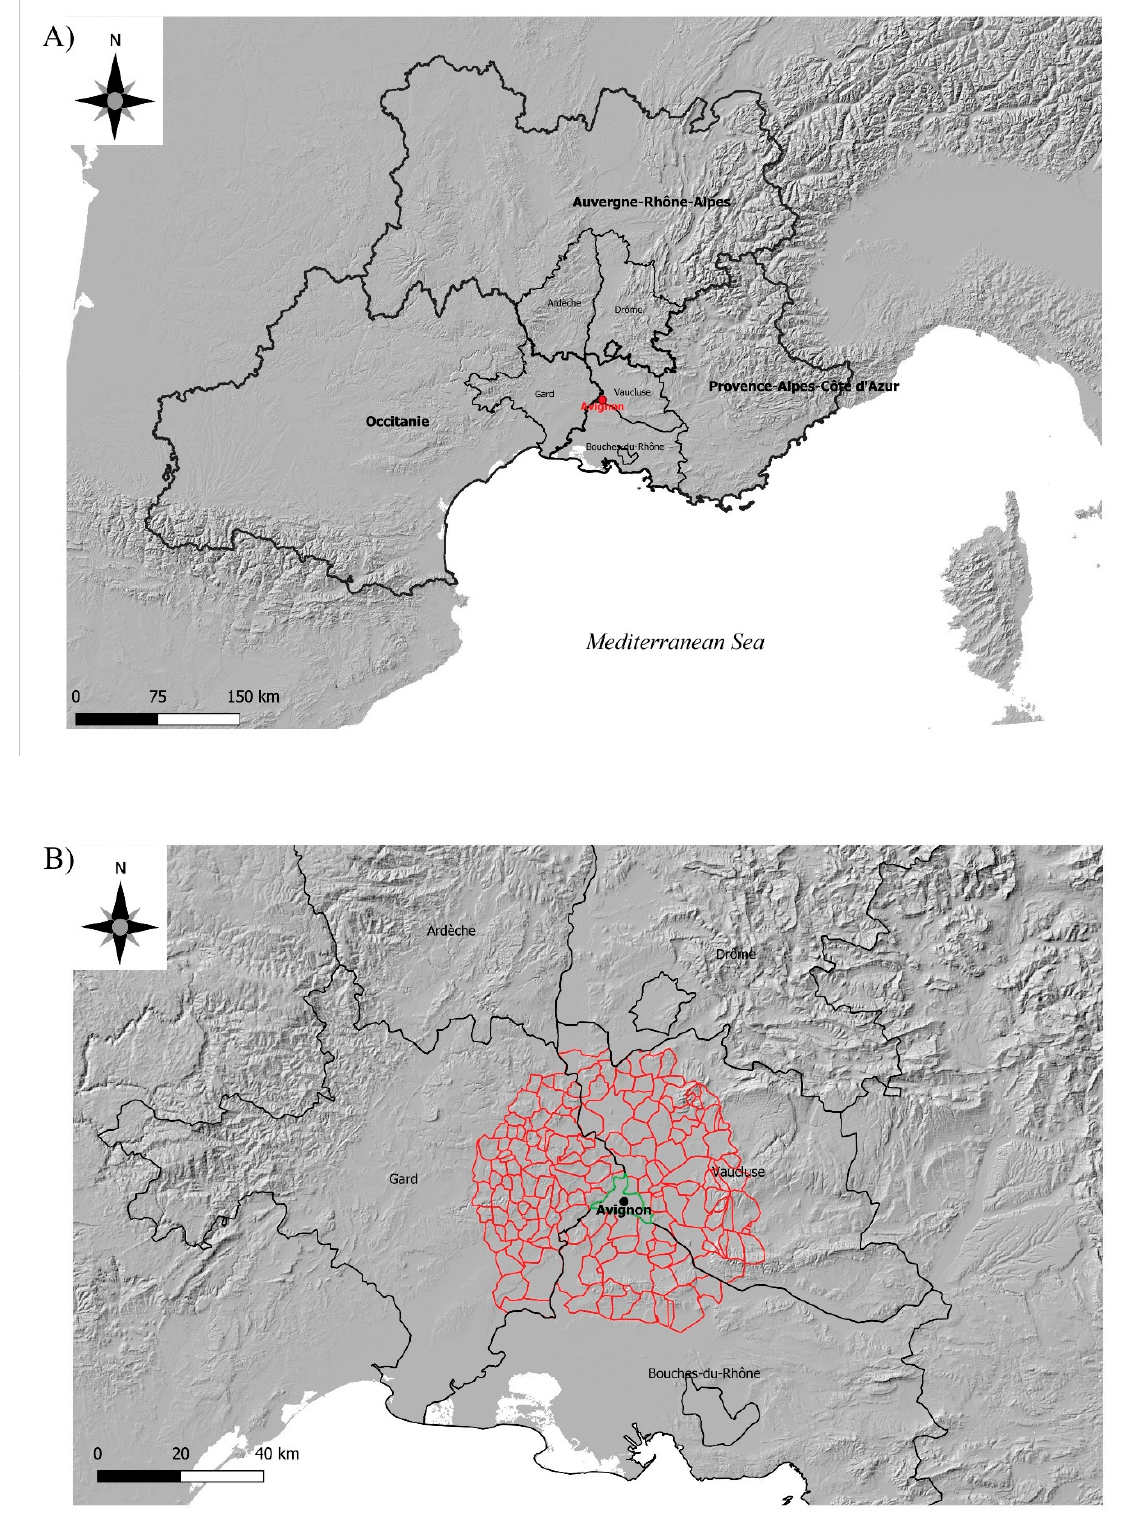
Figure 1. Location of Avignon (Vaucluse department) in South-East France, and the surrounding departments and regions (in bold) ( A ), and the location of the municipalities/communes (in red) forming the selected initial foodshed in a radius of 30 km around the municipality of Avignon (in green) ( B ). Note that the proposed foodshed belongs to two other departments (Gard and Bouches-du-Rhône), and is near the departments of Ardèche and Drôme to the North. Details on the population and surface area for each commune are given in the Supplementary Material (Tables S1–S3).